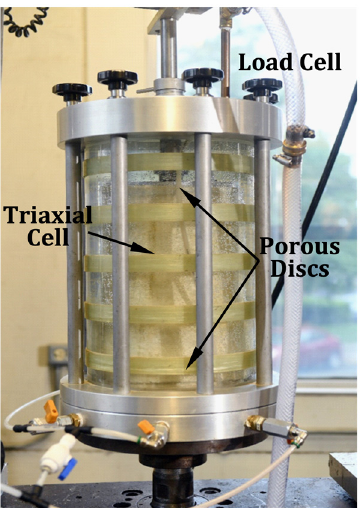
Figure 2. The large ‐ scale triaxial apparatus that was used in the experiments.